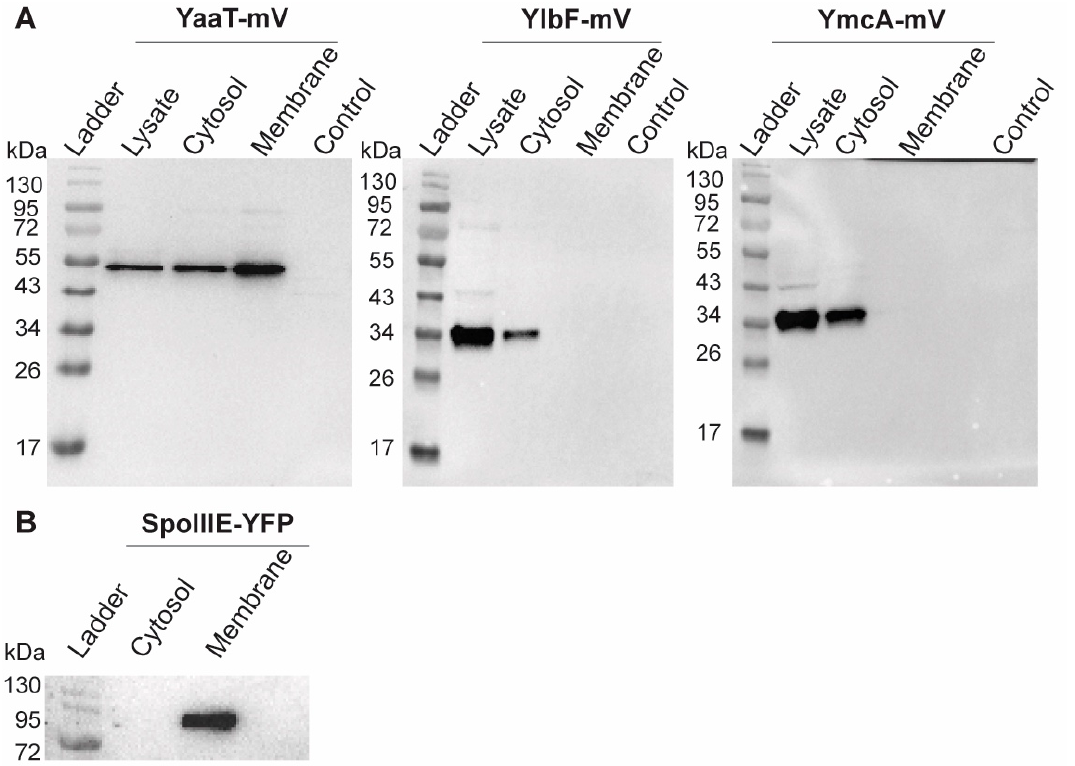
Figure 8. Western blots showing cell fractionation of ( A ) Y-complex proteins or ( B ) of SpoIIIE as mV or YFP fusions, respectively. Total cell extracts from exponentially growing cultures (LB) were used. The YaaT-mV fusion (57.9 kDa), YlbF-mV (43.7 kDa), YmcA (42.9 kDa) contains the mVenus polypeptide (26.9 kDa). Note that YlbF runs erroneously low, possibly because samples have not been heated before loading to the gel, which yields clearer bands. All strains were detected via GFP-antiserum. The fractionation was carried out by ultracentrifugation (100,000 × g ). The displayed fractions shown are full lysate, supernatant (Cytosol) and pellet (Membrane). “Control” BG214 wild type cells without mVenus